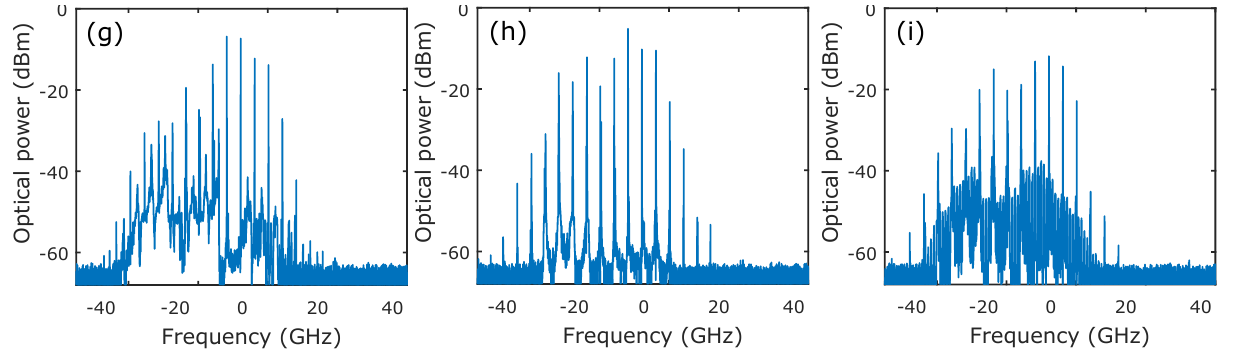
Figure 6. Bifurcation scenarios resulting in the excitation of the depressed polarization mode. These optical spectra are obtained for detuning ∆ ν = − 0.9 GHz and injected comb spacing Ω = 4 GHz. ( a , b ) Wave mixing at P inj = 3 µW and P inj = 32 µW, respectively, ( c , d ) single polarization comb at P inj = 48 µW and P inj = 228 µW, respectively, ( e , h , i ) two polarizations comb at P inj = 304 µW, P inj = 560 µW and P inj = 704 µW, respectively, ( f ) two polarization harmonics comb at P inj = 376 µW and ( g ) two polarization complex dynamics at P inj = 448 µW.